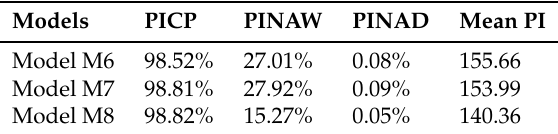
Table 6. Comparison of the best models using the PI Coverage Probability (PICP), PI normalised Average Width (PINAW) and PI normalised Average Deviation (PINAD) at 95% level of